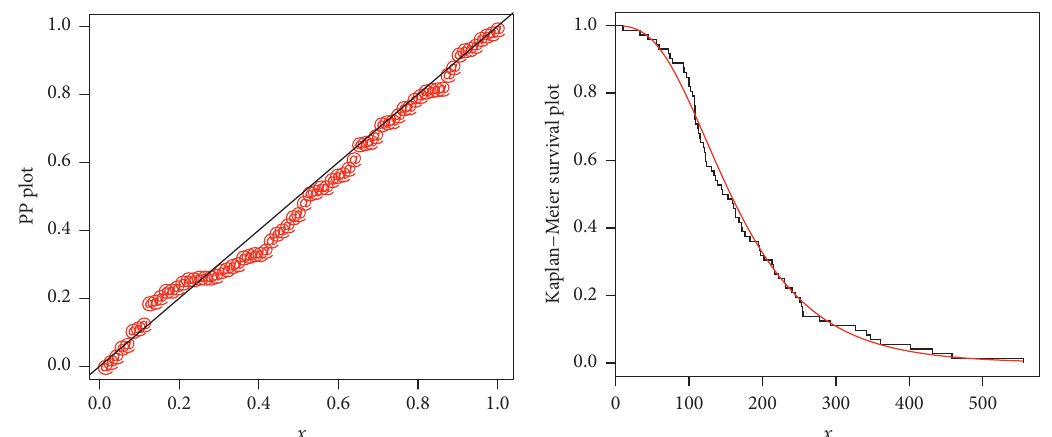
Figure 4: PP and Kaplan–Meier survival plots of the NE-W distribution for data 1. Table 6: Maximum likelihood estimates with standard errors (in parenthesis) of the fitted distributions for data 2. Dist.